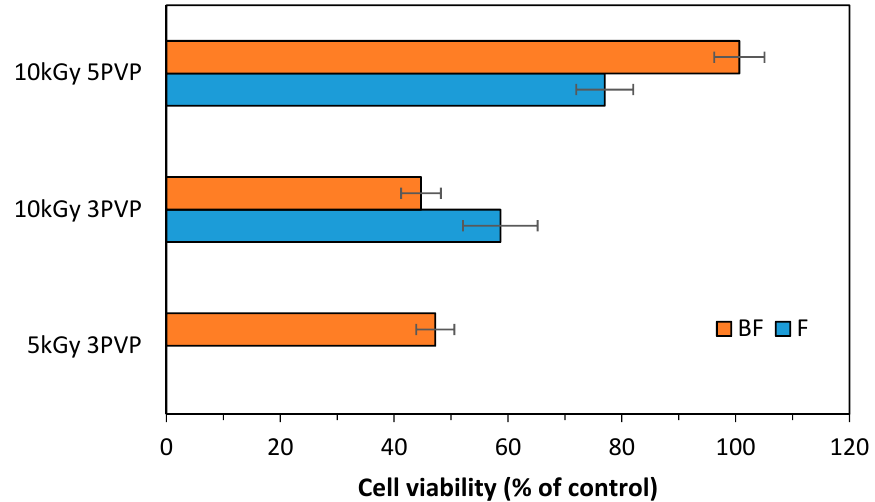
Figure 8. In vitro cellular viability (mean ± SD, n = 3) at day 1 of HFFF2 cultured on chitosan/PVP (radiation dose, 5 and 10 kGy; PVP content, 3% and 5%; methodology, with and without N 2 bubbling, BF and F respectively).